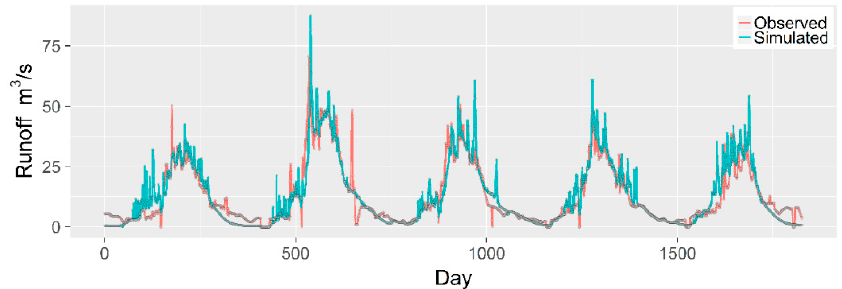
Figure 7. Daily runoff (2009–2013) of Jinghe mountain station derived from the SWAT model driven by the CMADS.